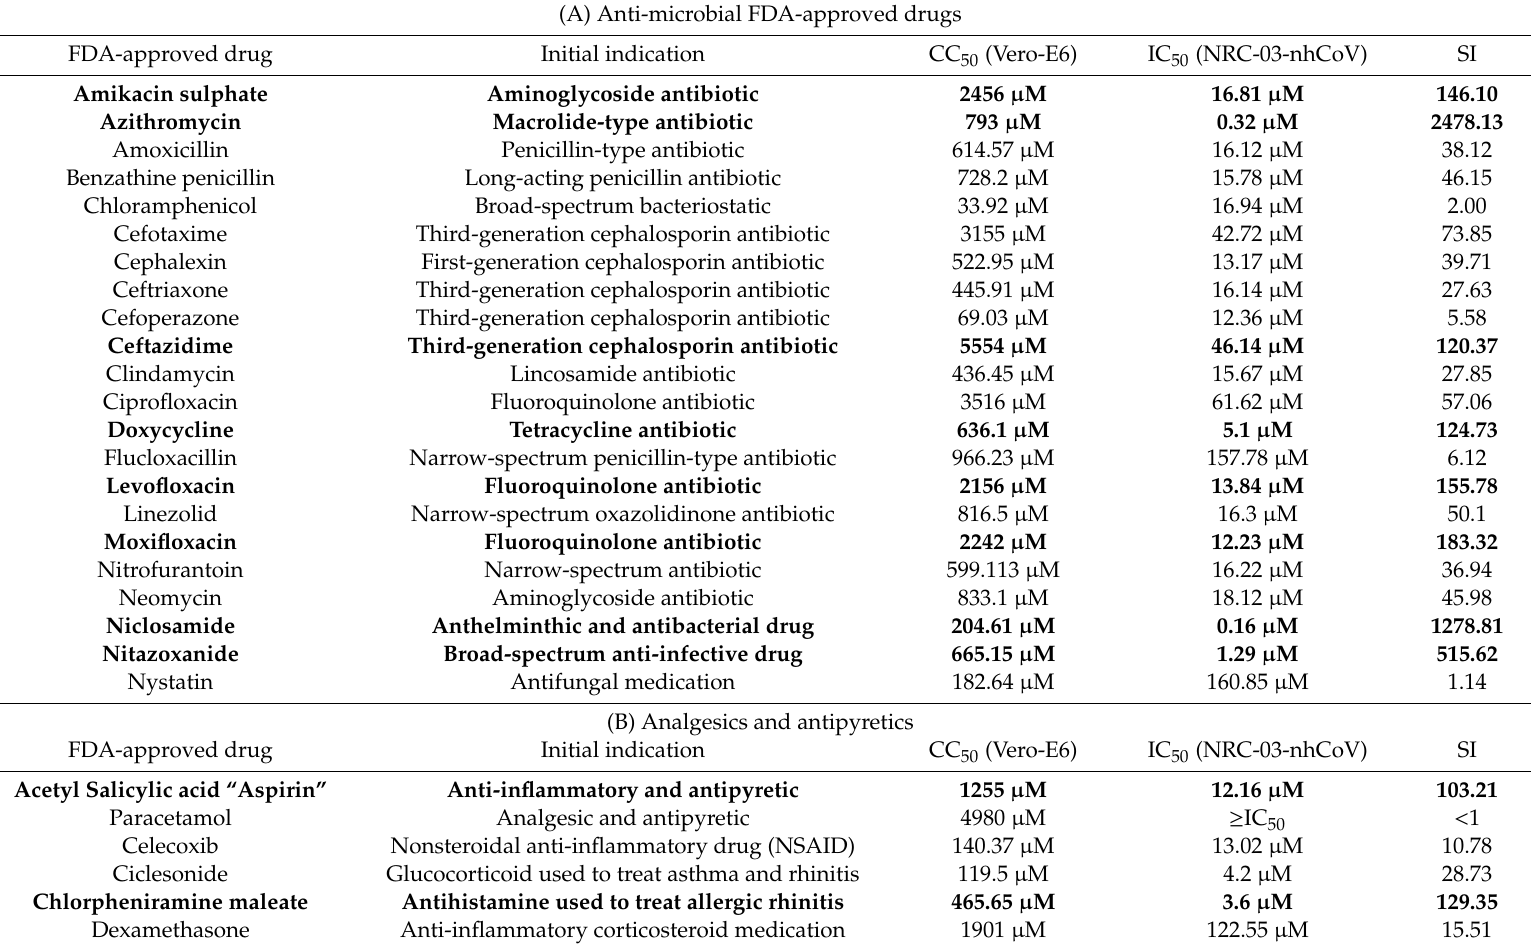
Table 1. Antiviral activity of anti-microbial and anti-inflammatory FDA-approved drugs against NRC-03-nhCoV. (A) Anti-microbial FDA-approved drugs FDA-approved